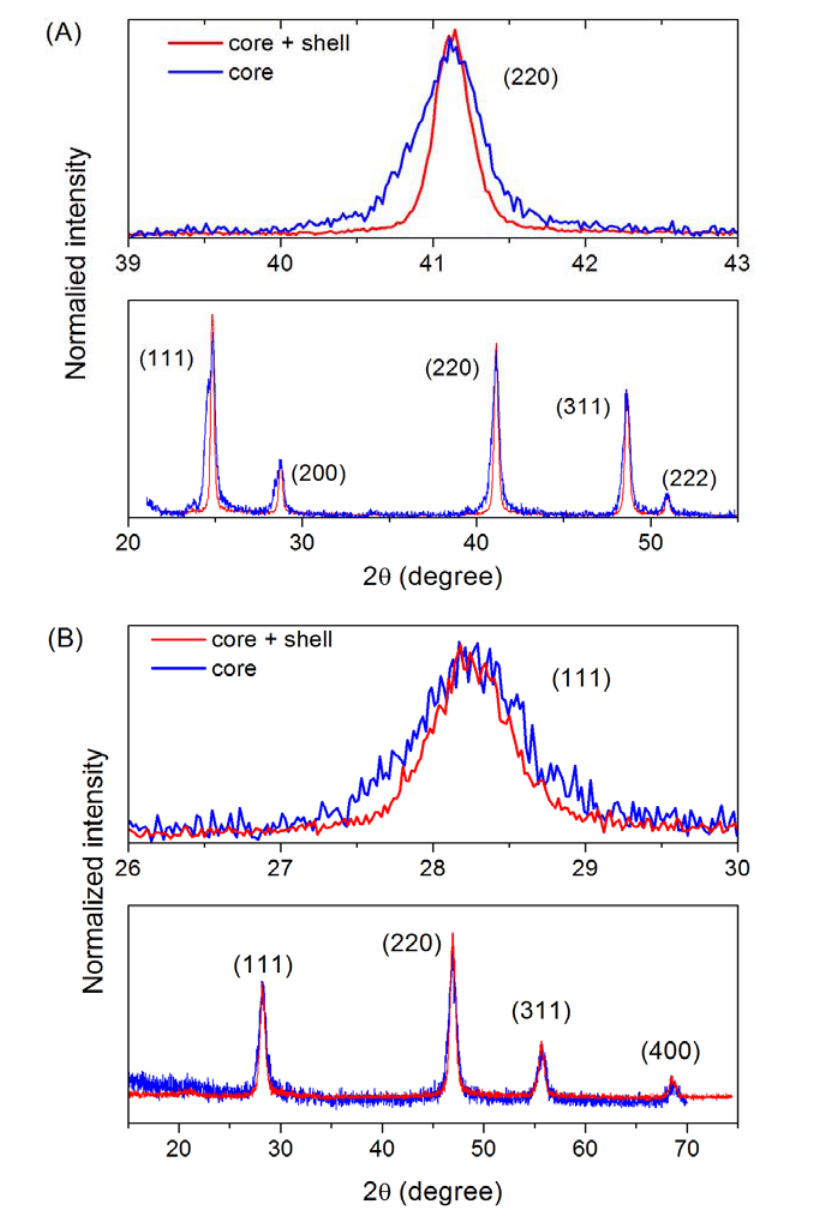
/BaF and CaF :Eu/CaF , 2 2 2 2